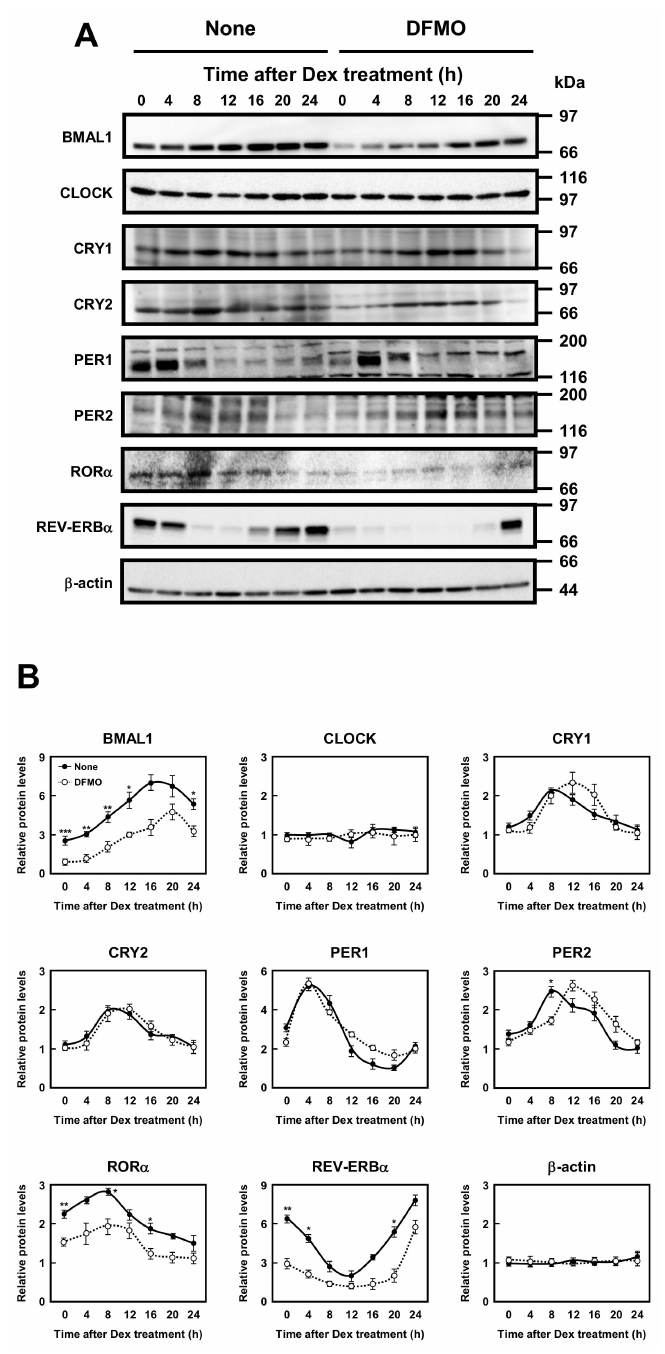
Figure 3. Measurement of protein level of circadian clock genes. ( A , B ) Temporal protein expression encoded by the circadian clock genes in control and DFMO-treated NIH3T3 cells were determined by Western blotting. The levels of circadian genes were normalized to β -actin and presented as relative expression. * p < 0.05; ** p < 0.01; *** p <